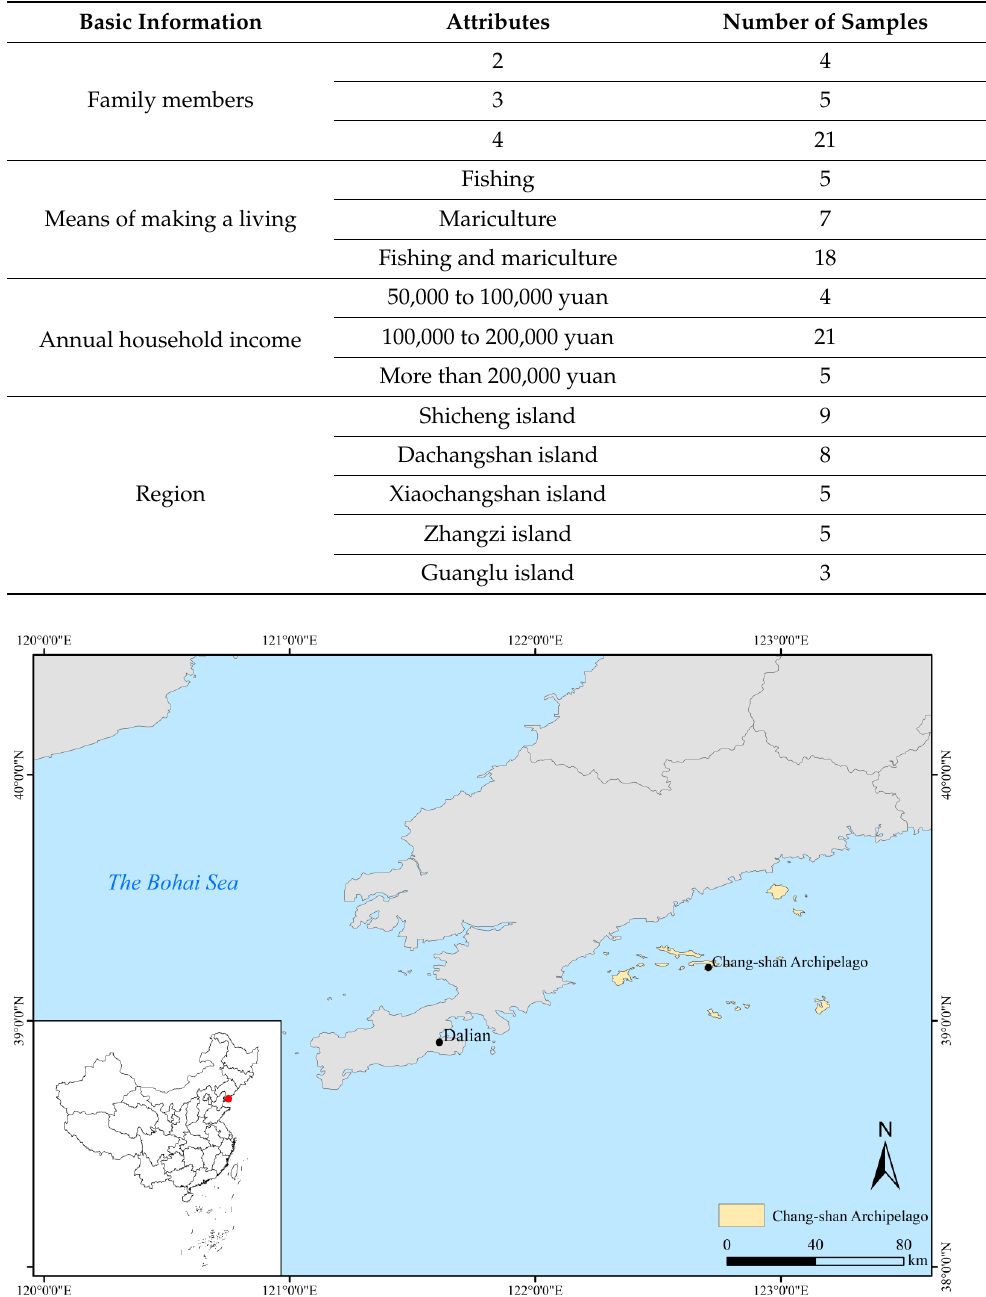
Table 1. Basic information of interviewed fishing households.